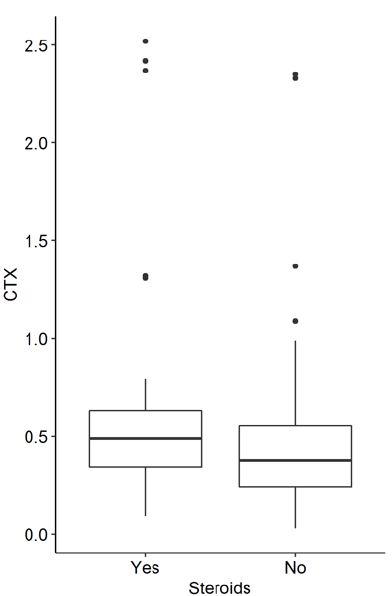
Figure 2. CTX levels in IBD patients with and without steroids ( p = 0.013).